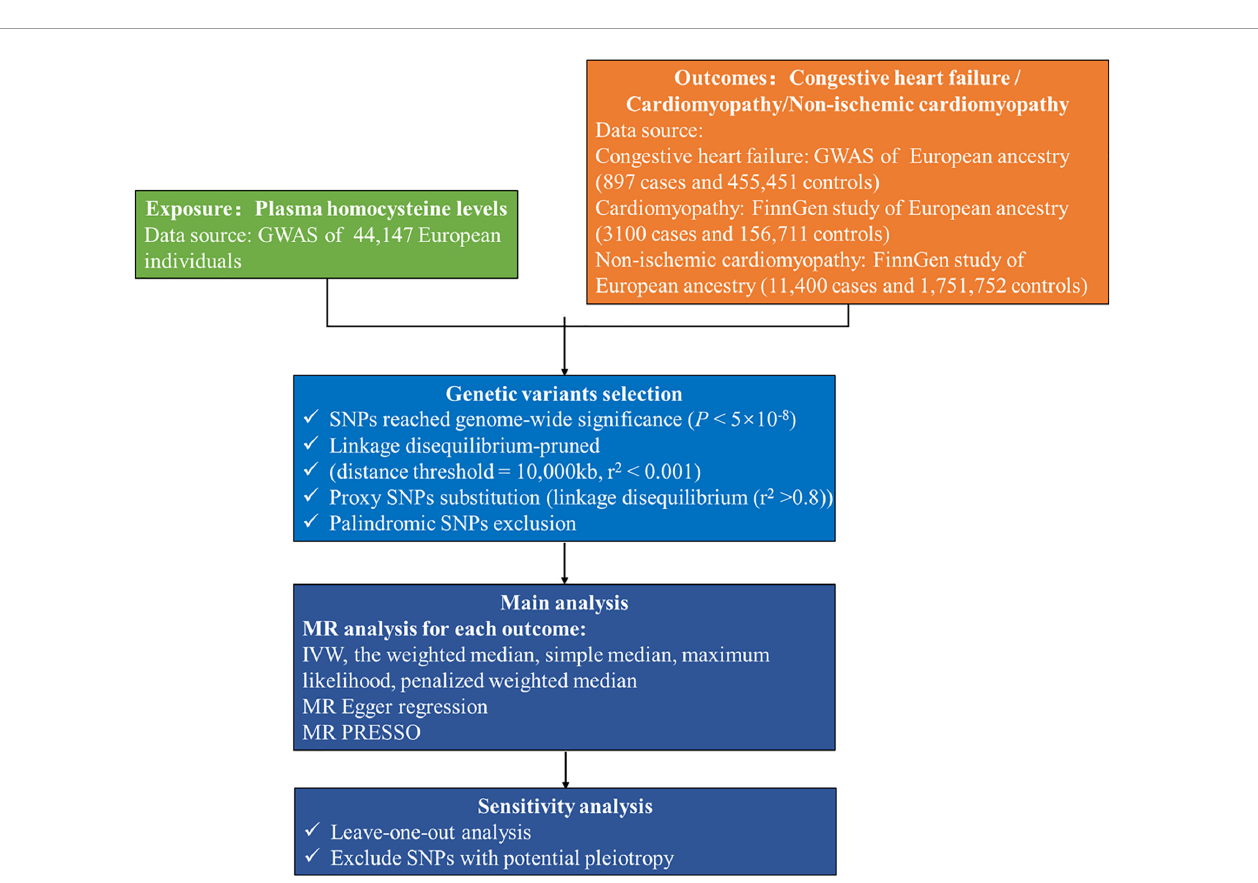
effects on diseases (22). To minimize potential weak instrument bias, we considered an F-statistic of at least 10 as sufficient for performing an MR analysis. The F statistics can be calculated as 2 ( N − 1 − k ) F = R ( 1 − R 2 ) k , where N stands for the sample size, k stands for the number of IVs, and R 2 stands for the percentage of the